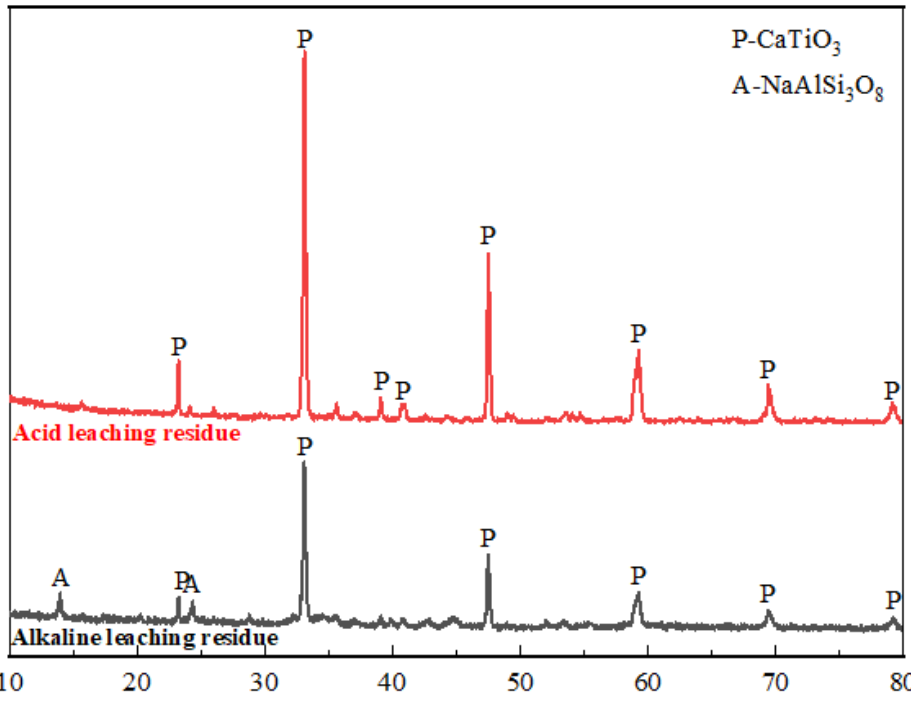
Figure 11. XRD pattern of various leaching residues.